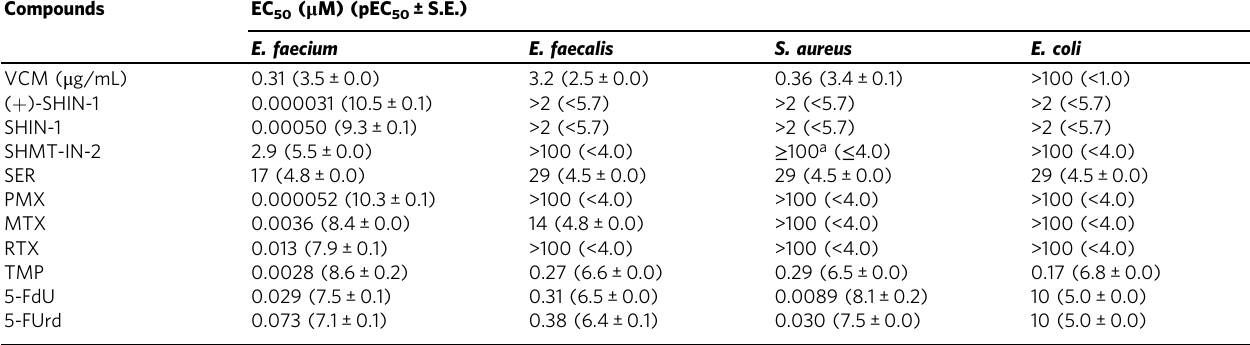
Table 1 Antibacterial activities of folate-mediated 1C metabolism inhibitors against four microorganisms. Compounds